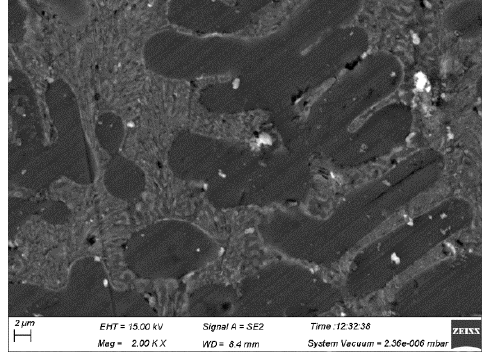
Figure 6. Microstructure of the as-cast brazing filler metal.